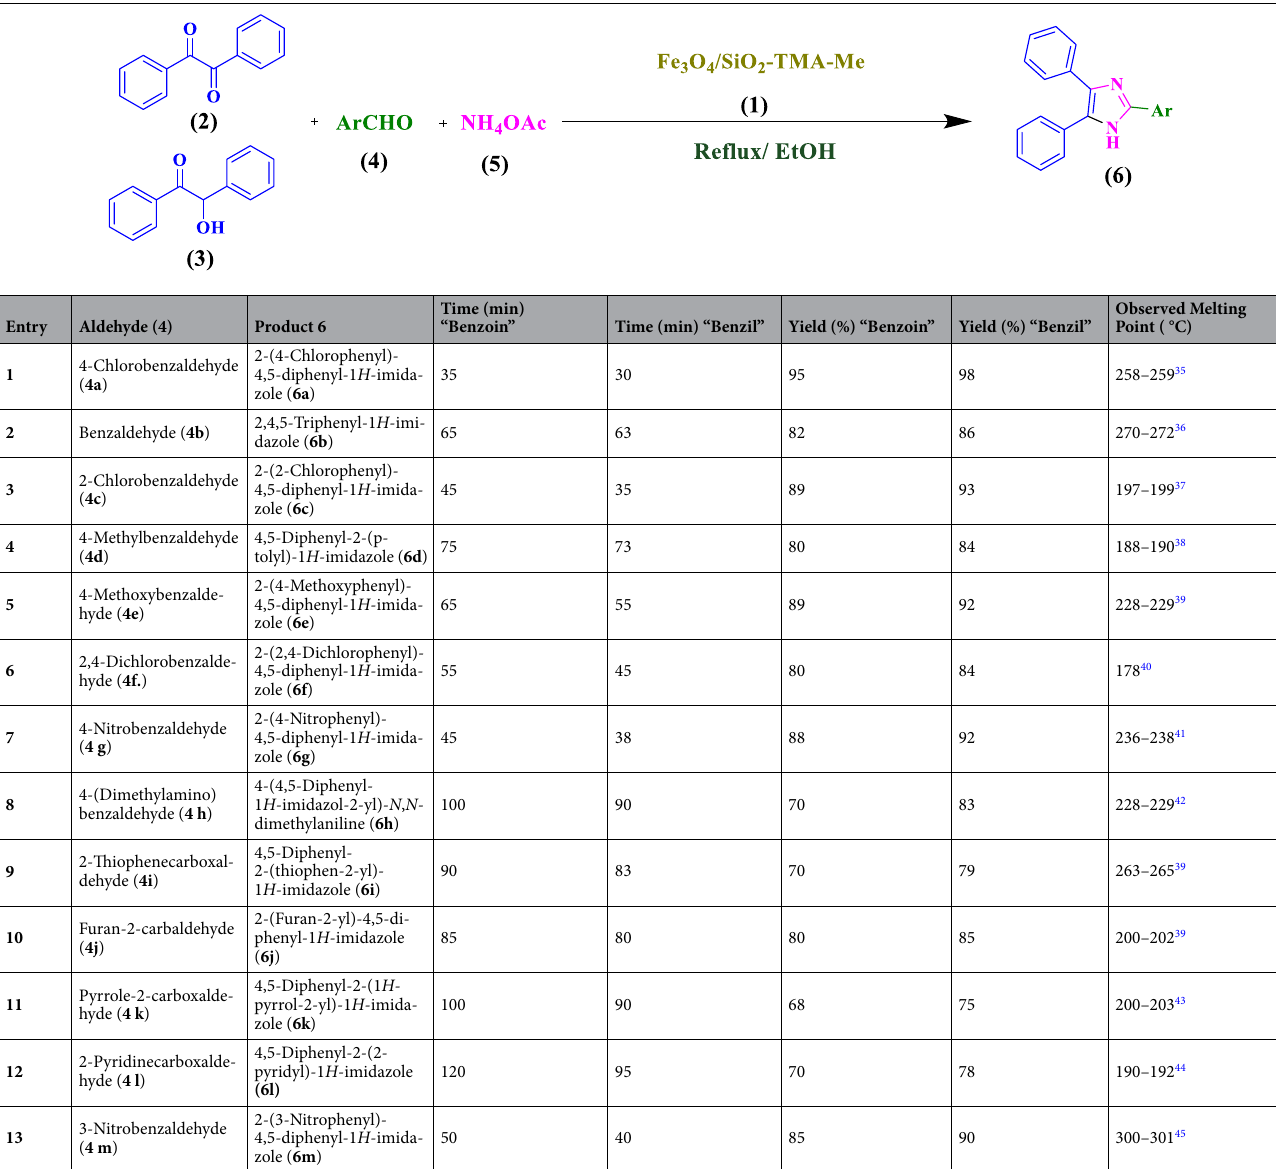
Table 2. Scope of the three-component synthesis of imidazole derivatives catalyzed by the Fe 3 O 4 /SiO 2 - TMA-Me ( 1 ) nanocomposite a . a Reaction conditions: benzil or benzoin ( 2 or 3 , 1 mmol), aldehyde